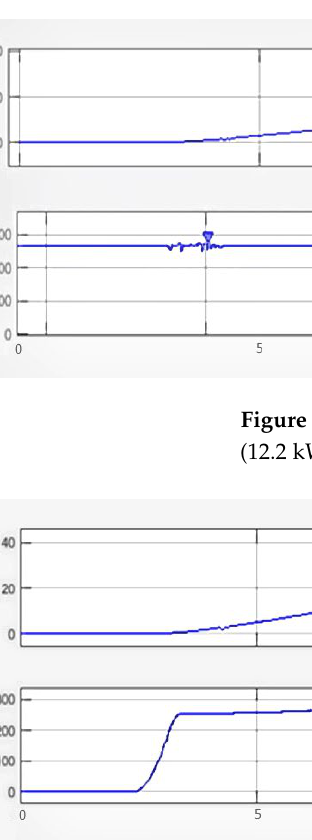
Figure 19. Daily waveform of power generated by the modules and the average voltage at the out- put of the PV modules (39.65 kW) on a sample day in July. The theoretical maximum power generated by the installation can be calculated from the following formula [19]: 𝑃𝑃 𝑚𝑚𝑚𝑚𝑚𝑚 = 𝑃𝑃 ∙ 𝑍𝑍 ∙ 𝑁𝑁 (5) where 𝑃𝑃 —power of a single module; 𝑍𝑍 —number of chains; 𝑁𝑁 —number of modules in a chain. For example, for an installation consisting of 26 chains, each with 5·305 W modules: 𝑃𝑃 𝑚𝑚𝑚𝑚𝑚𝑚 = 305 ∙ 26 ∙ 5 = 39.65 kW However, the simulations were not conducted under STC conditions (irradiance = 1000 W/m 2 , module temperature = 25 °C). For this reason, the actual power generated dif- fers significantly from the theoretical values. These differences are most evident during the winter months, when the average irradiance is even 10-fold lower than under STC conditions. Table 1 shows a comparison between the theoretical values of the power that should be generated and the values obtained in the simulations. It can be observed that the maximum momentary power values obtained from the simulated operation of the installation in Simulink reach values close to the maximum theoretical power. This is due to the good conditions of the irradiance, which at its peak time, at 10:02 a.m., was 1034 W/m 2 .